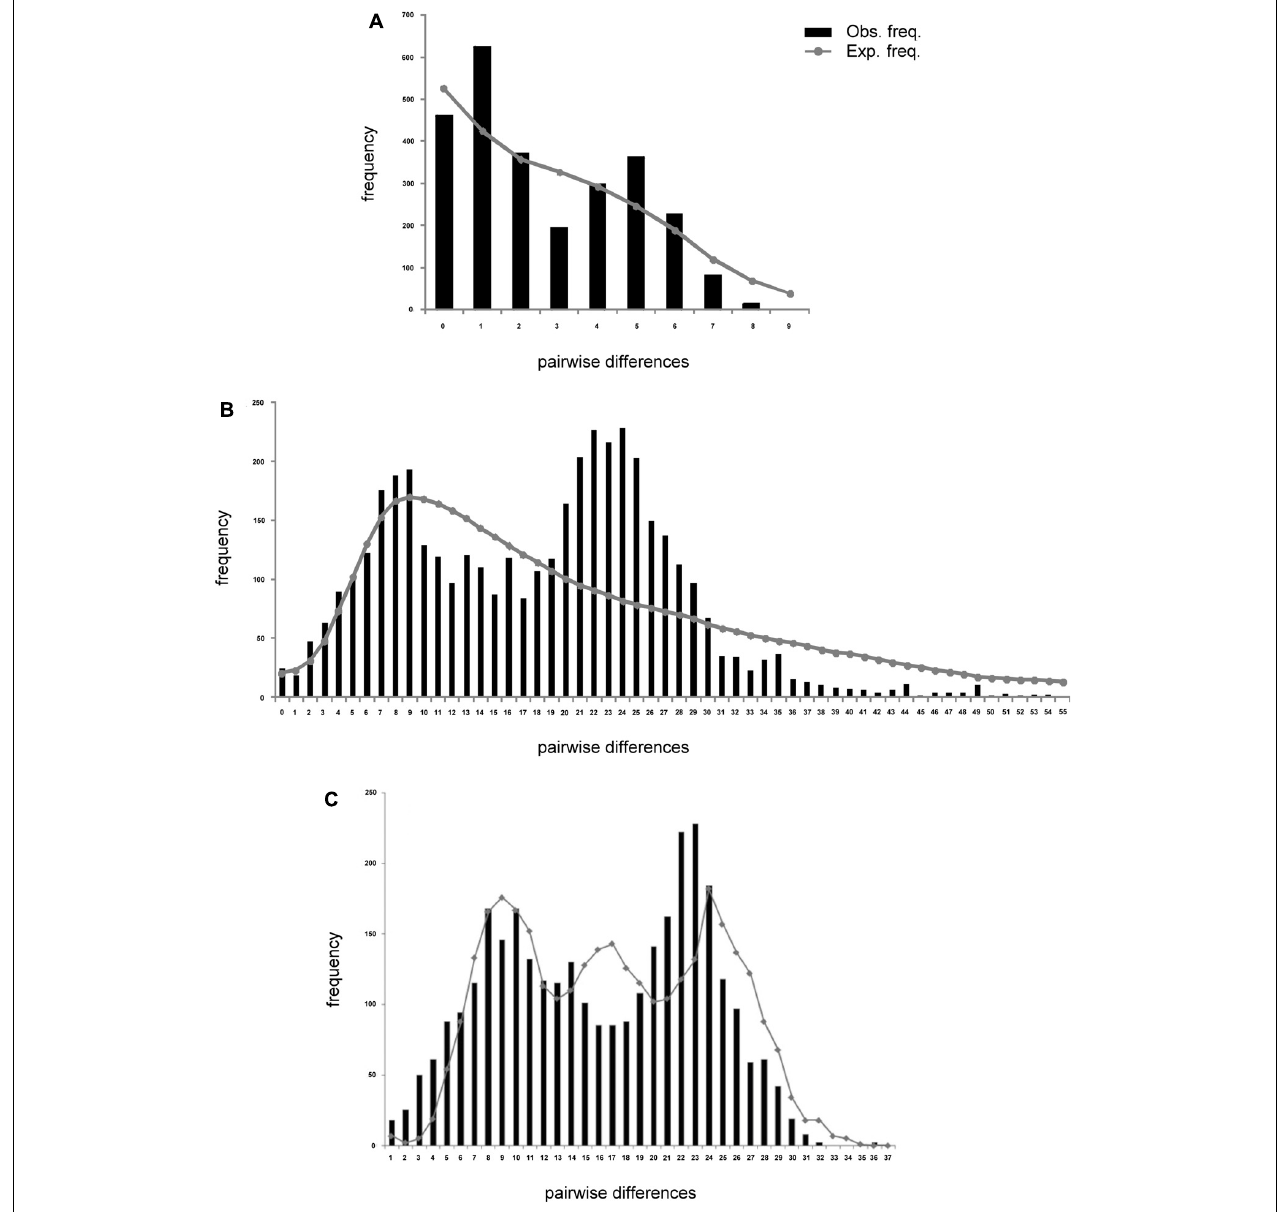
FIGURE 3 | Mismatch distribution plots of Lutjanus analis (A,B) and Lutjanus jocu (C) . mtDNA cytB (A) , and HVR1 control region sequences (B,C) . The observed distribution is represented by vertical bars. The expected distribution, as predicted by the population expansion model, is represented by a solid